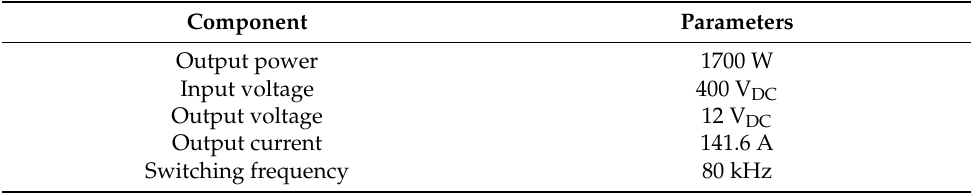
Table 1. Phase shift full-bridge converter